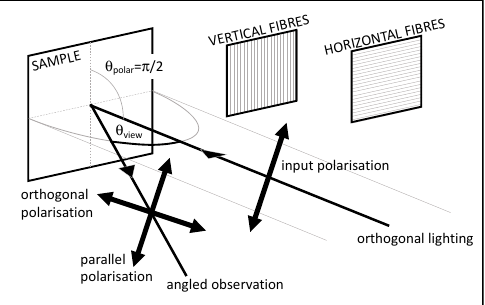
Figure 1. Experimental geometry. A sample is orthogonally illuminated by incoherent linearly-polarized light. A camera records images of the sample surface at different azimuthal angles θ view , performing a selection of the observed light polarizations, both parallel and orthogonal to the input one.